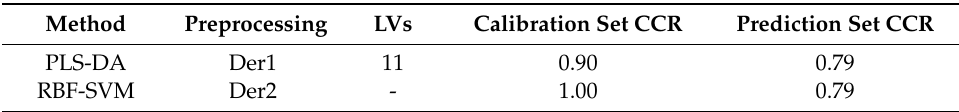
Table 2. Performance of models based on visible and near-infrared (VNIR) full wavelengths with optimal preprocessing. LV: latent variable; CCR: correct classification rate 1 .